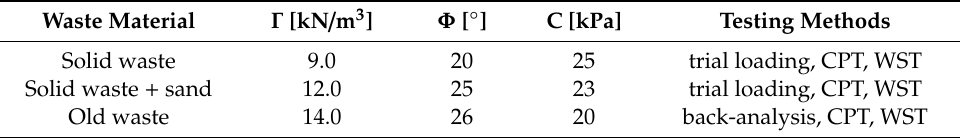
Table 1. Shear strength parameters for municipal solid waste obtained from diver’s approaches.